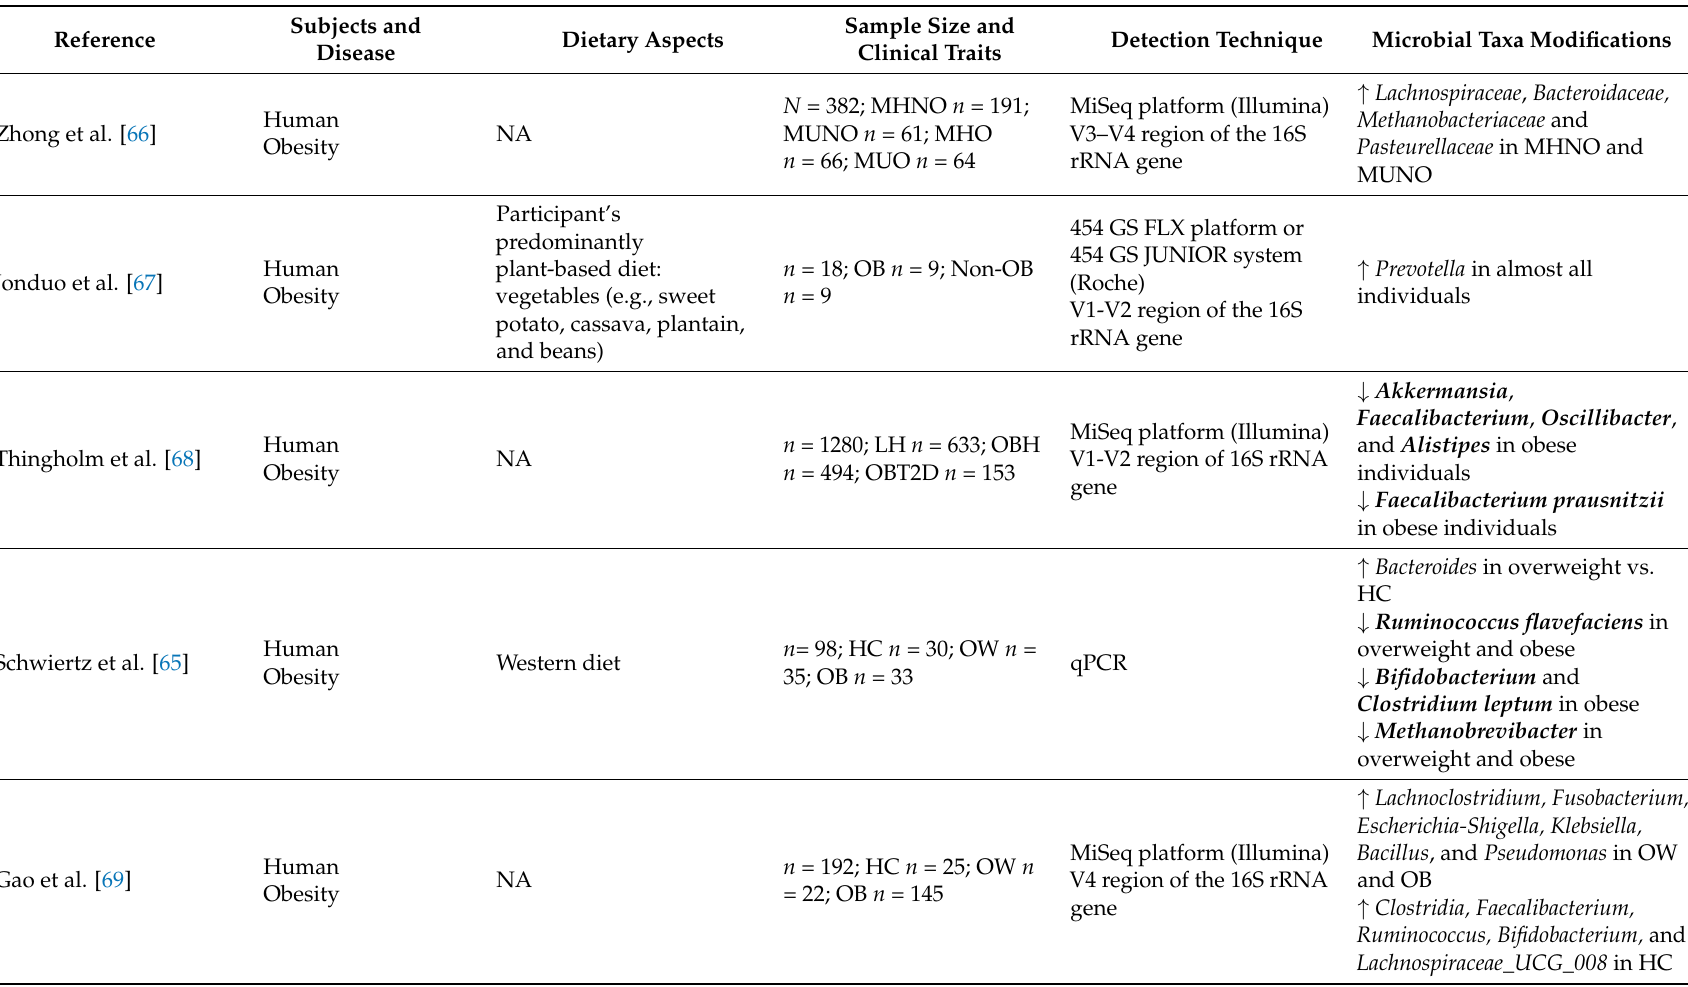
Table 3. Clinical trials and variations of the main microbiota taxa found in specimens from patients suffering metabolic- and endocrine-related